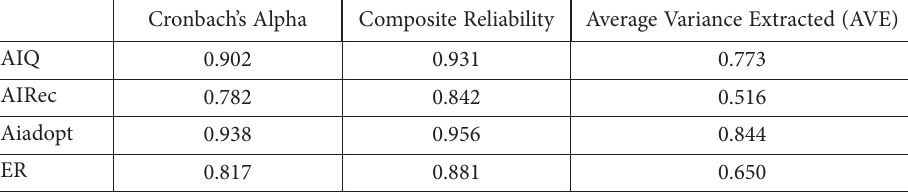
Table 1. Measurement